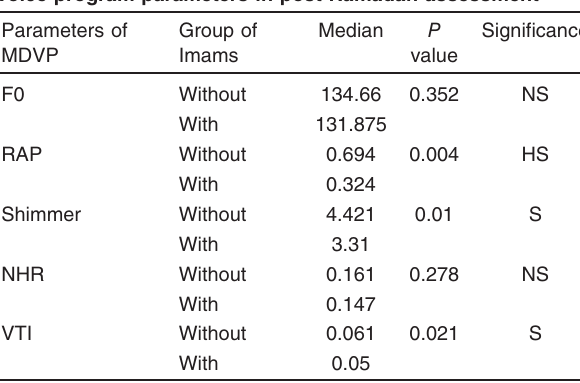
Table 4 Comparison between the results of the first group and the control group according to the multidimensional voice program parameters in post-Ramadan assessment Parameters of MDVP